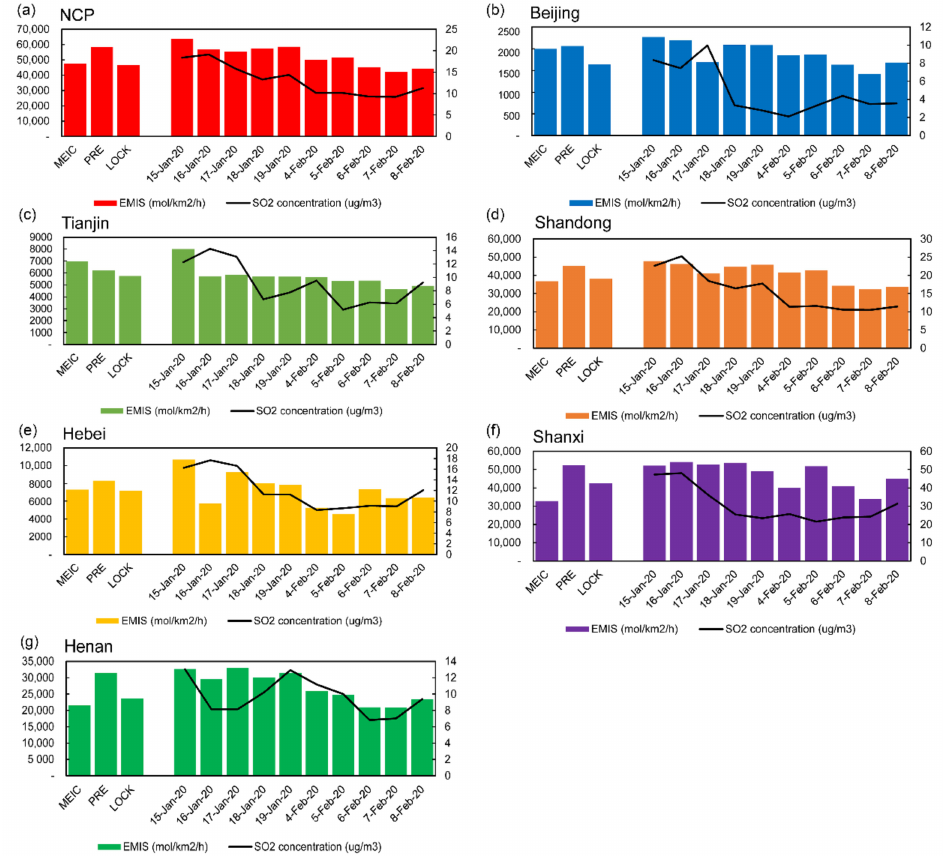
Figure 5. The amounts of SO 2 emissions for MEIC, pre-lockdown optimized inventory, lockdown optimized inventory, daily inventories, and SO 2 observations in different regions: ( a ) NCP, ( b ) Beijing, ( c ) Tianjin, ( d ) Shandong, ( e ) Hebei, ( f ) Shanxi, and ( g ) Henan (units: mol/km 2 /h). The bars represent emissions and the black lines represent